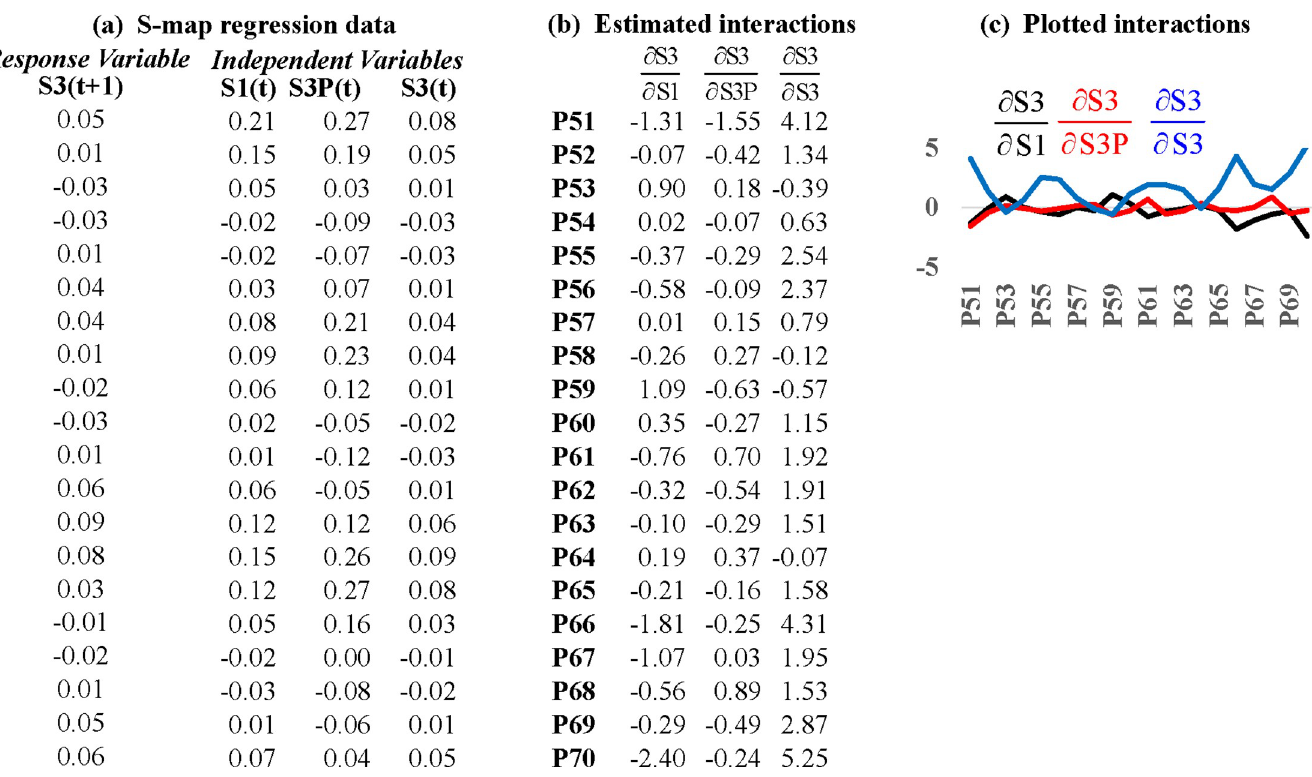
Fig 7. The S-mapping method of quantifying causal interactions. The S-mapping method [16] relies on a locally-weighted multivariate linear regression scheme to map out the curvature of a reconstructed attractor. This is used to compute directional derivatives that quantify marginal changes in a selected response variable to incremental changes in the others. In this example, we reconstruct an attractor with signals for S1, S3, and S3P, and take S3 as the response variable. (a) These signals are inputted into the locally-weighted regression scheme at a given reference point (struck out in gray); (b) Columns of this matrix are estimated regression coefficients and measure the interactions between S3 and the other variables; and (c) The interactions are plotted through